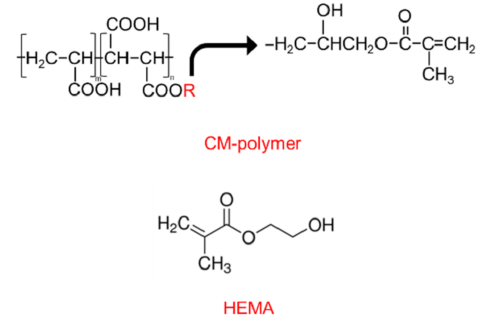
Figure 1. Chemical structure of the CM polymer and 2-hydroxyethyl methacrylate (HEMA).